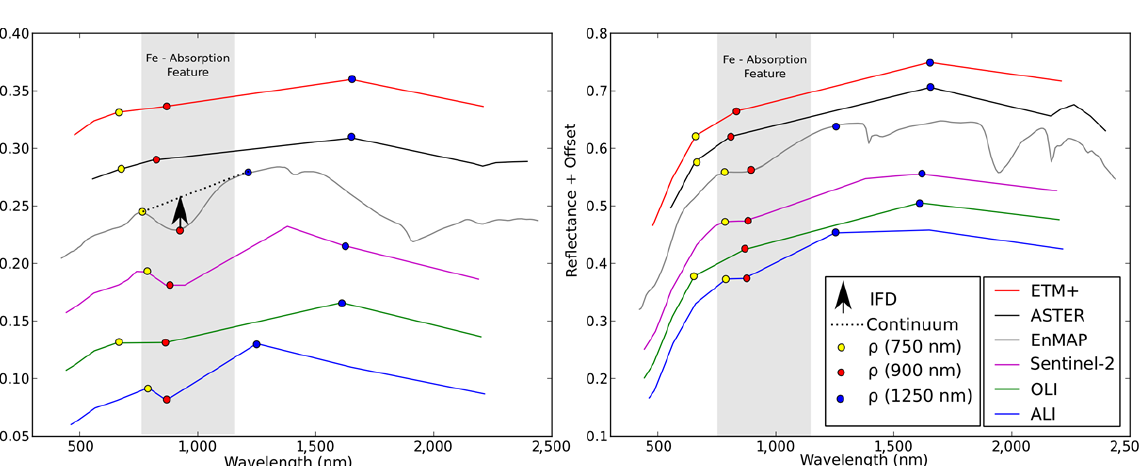
Figure 6. Spectra of multiple sensors generated from spectral resampling of the point spread function weighed field spectra from platinum mine tailings ( left ) and from mine waste associated with gold mining ( right ). Note that only EnMAP, Sentinel-2, ALI and OLI are able to spectrally resolve the iron absorption feature at 900 nm in the case of the material associated with platinum mining (left). The EnMAP reference spectrum is in grey at the original reflectance level; all other spectra are successively offset by 0.05 for